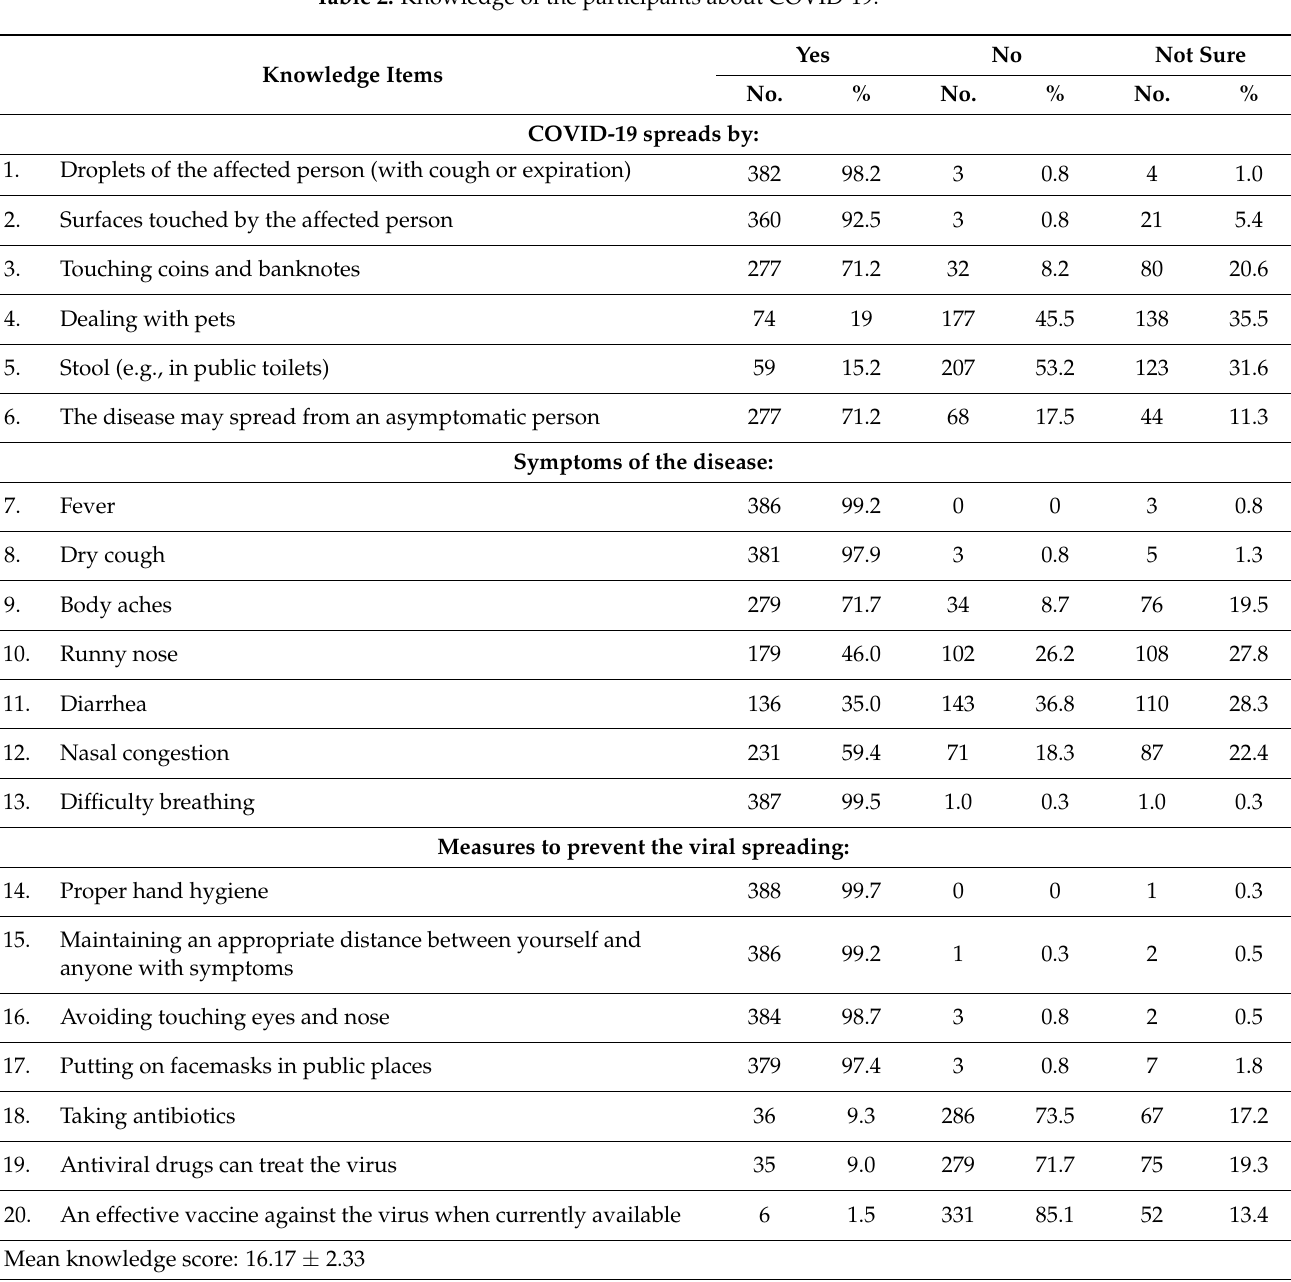
Table 2. Knowledge of the participants about